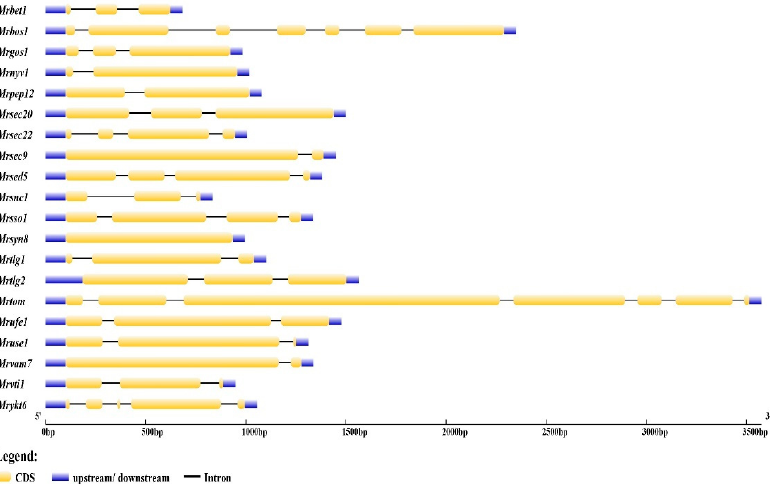
Figure 1. Exon–intron structure of MrSNAREs . Blue boxes represent upstream and downstream untranslated regions; yellow boxes represent the CDS; and black lines represent the introns. Table 1. Physicochemical parameters of identified MrSNAREs .